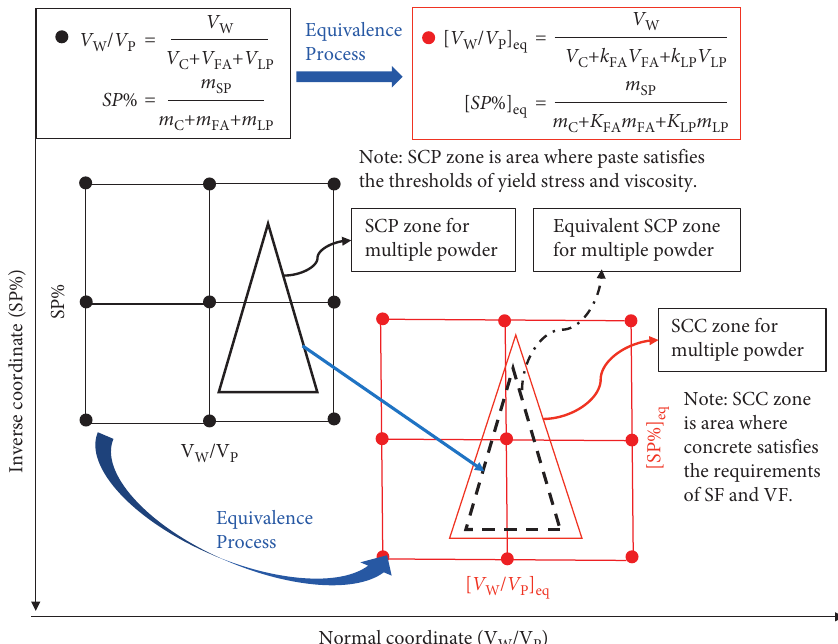
Figure 4: The theoretical framework of the powder equivalence model.